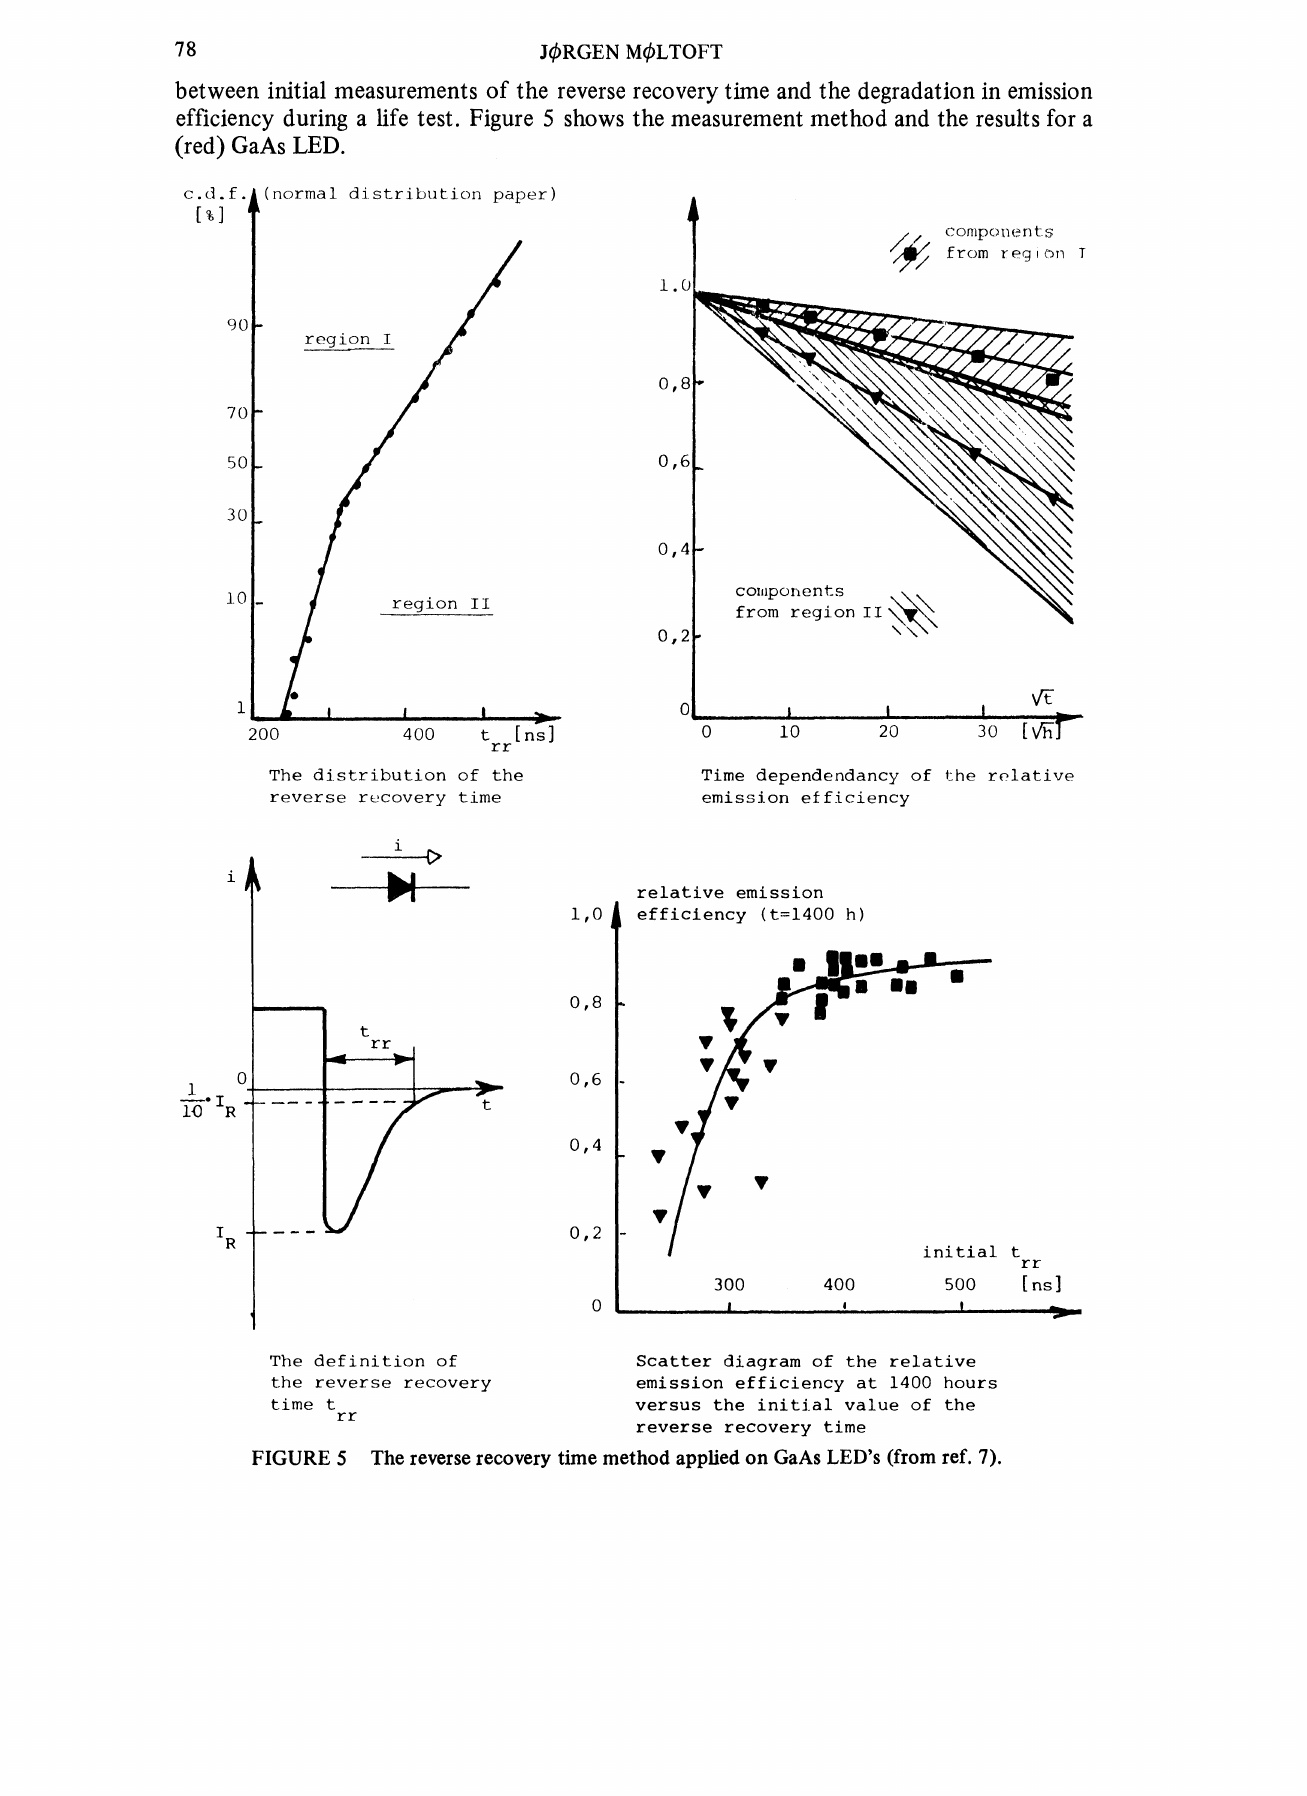
FIGURE 5 The reverse recovery time method apped on GaAs LED’s (om ref.